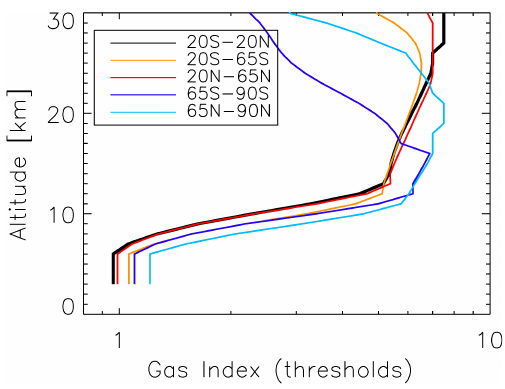
Fig. 3. Threshold profiles applied in the CIOPT THRESH detection method of the MIPclouds processor (V1.6) based on the gas index analysis for MIPAS band